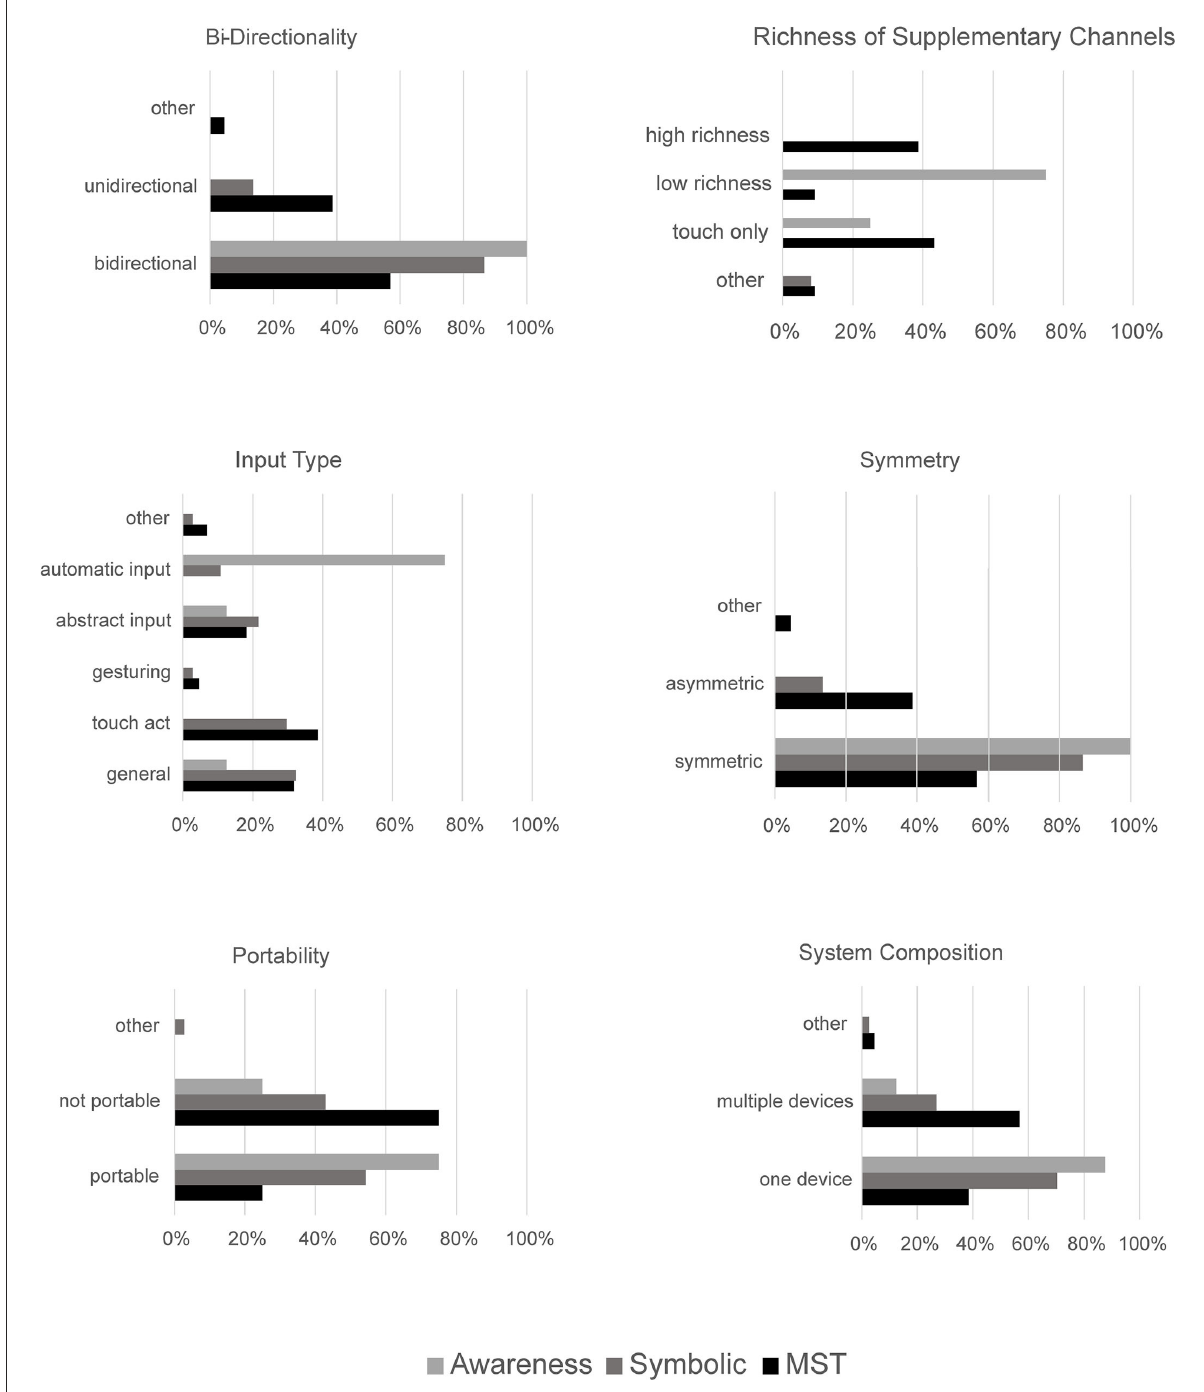
FIGURE2 Bar graphs of the dimensions which were found to have significant differences between the types of AHDs. Each bar represents the percentage of devices within a certain AHD type classified to have that design characteristic.